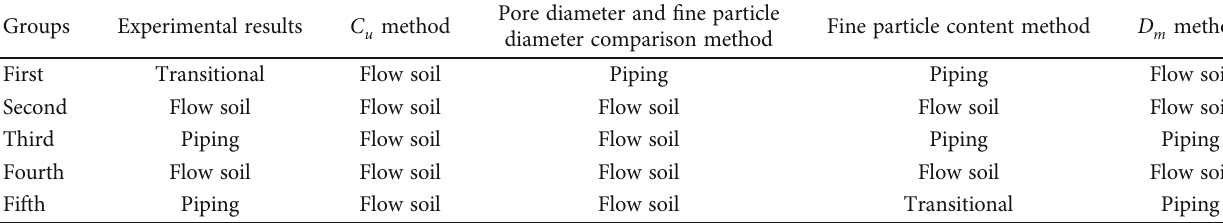
Figure 13: Relationship curve between D Table 4: Comparison of seepage failure type with di ff erent judgment methods.